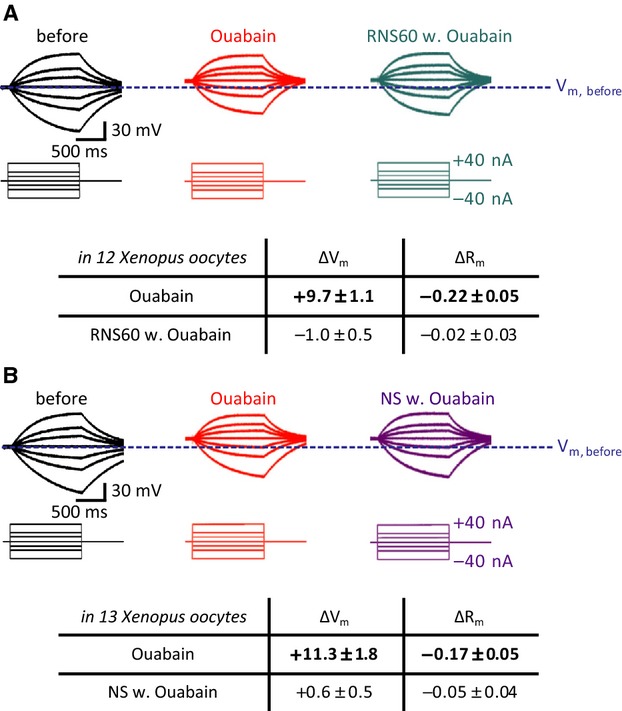
RNS60 effect on Xenopus laevis oocyte membrane potential and input resistance following ouabain Na+/K+ ATPs block. In (A) Control, left set of recordings (in black), resting potential and input resistance recordings before ouabain administration. In red similar set of recordings 10 min following 100 μmol/L ouabain administration. The oocyte resting potential was reduced by nearly 10 mV (P < 0.001 by paired t-test). In addition, a significant decrease in membrane input resistance was also registered (P < 0.05 by paired t-test). In green, following ouabain addition of RNS60 did not modify X. laevis oocyte resting potential or membrane resistance (results from 13 different oocyte experiments). In (B) a similar set of recordings as in (A). The last set in purple demonstrates no change of membrane properties in normal saline solution with ouabain (results from 10 different oocyte experiments).